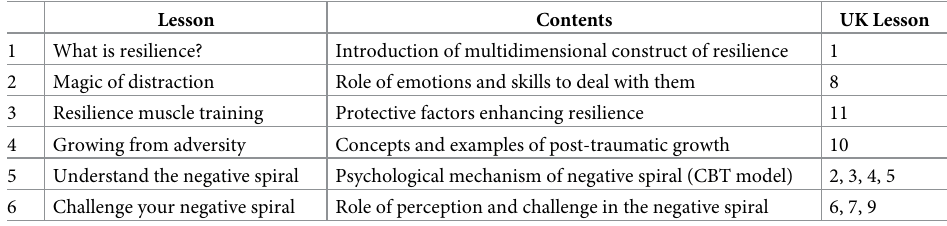
Table 1. Japanese version of the SPARK resilience program with reference to the UK